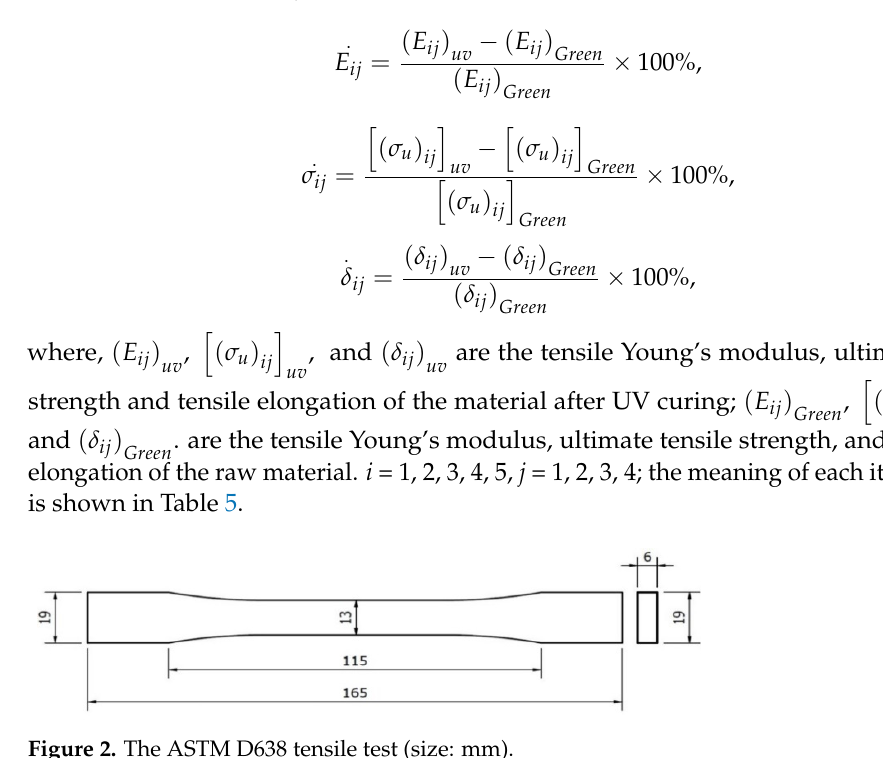
Figure 2. The ASTM D638 tensile test (size: mm).